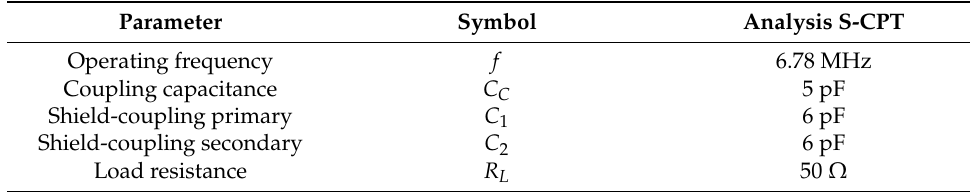
Table 1. Analysis test parameters of the S-CPT system.